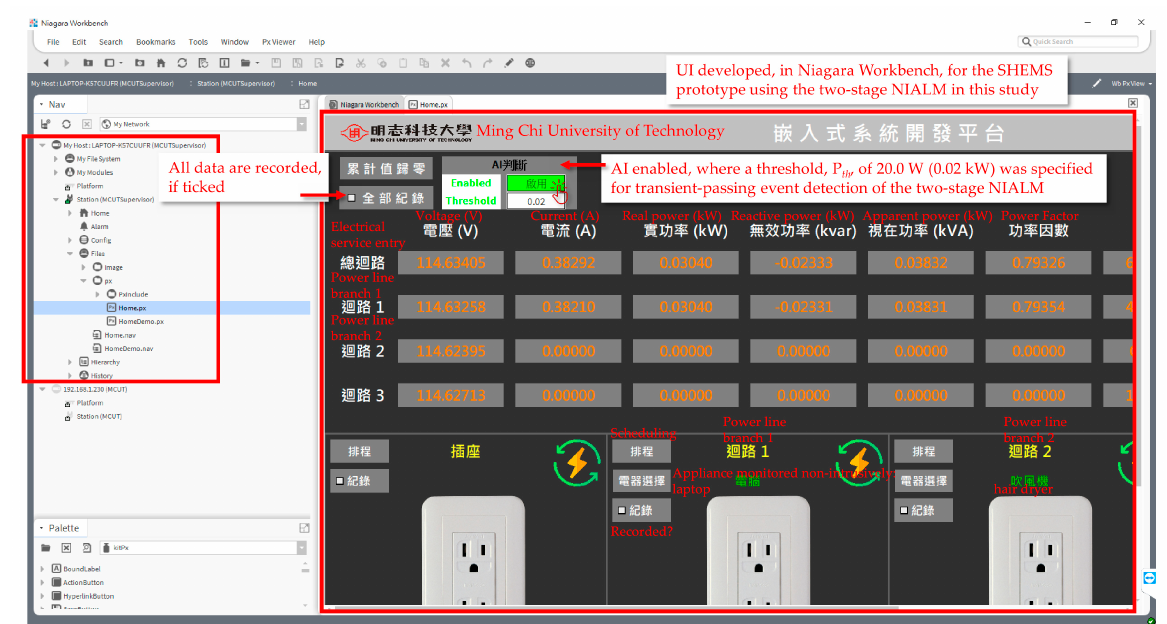
Figure 10. Remote deployment of the well-trained and -tested feed-forward ANN in cloud computing: ( a ) An executable Jar (Java ARchive) file was upgraded; ( b ) the upgraded executable Jar file is executed on the networked, embedded eSEMC as Edge AI.